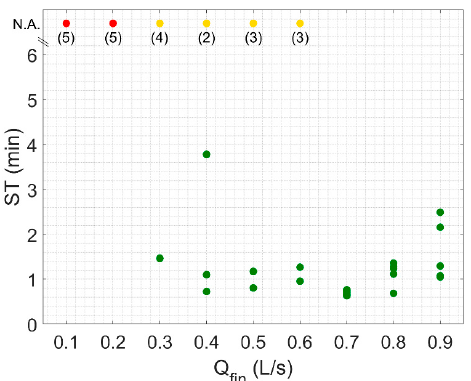
Figure 6. Stabilisation time intervals (or STs) in relation to the final flow rate Q fin characterising the five repetitions of each test configuration. The green dots indicate repetitions of the tests in which the set-point was reached, the yellow dots indicate the repetitions in which the set-point was not reached; the unstable behaviour is highlighted with red dots. The number of repetitions of the tests in which the particular behaviour occurred is given in round brackets below the yellow and red dots.